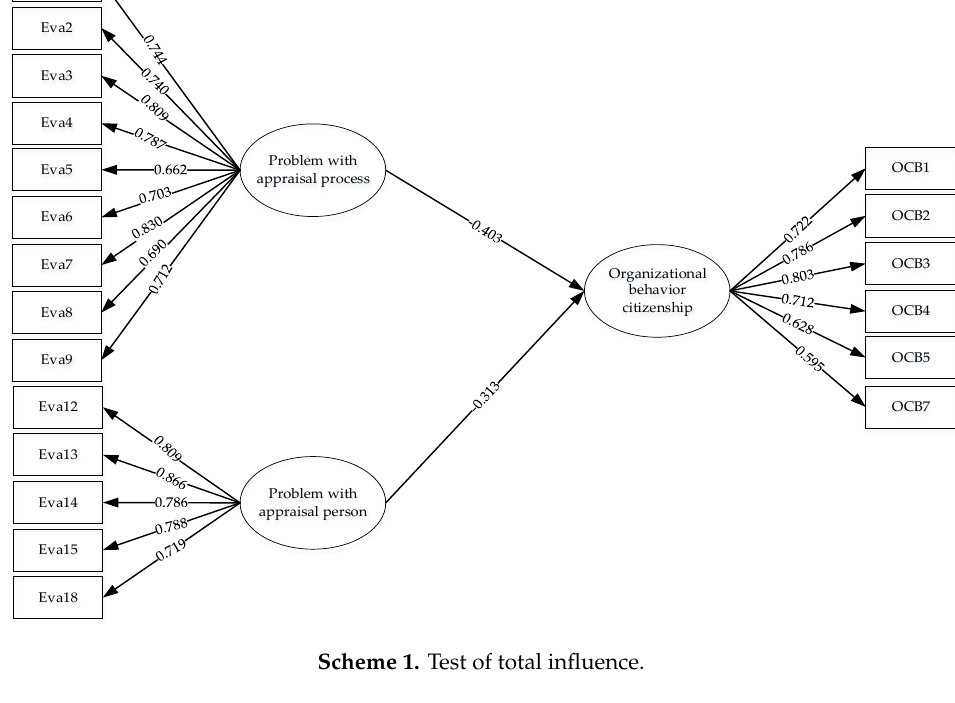
Scheme 1. Test of total influence.